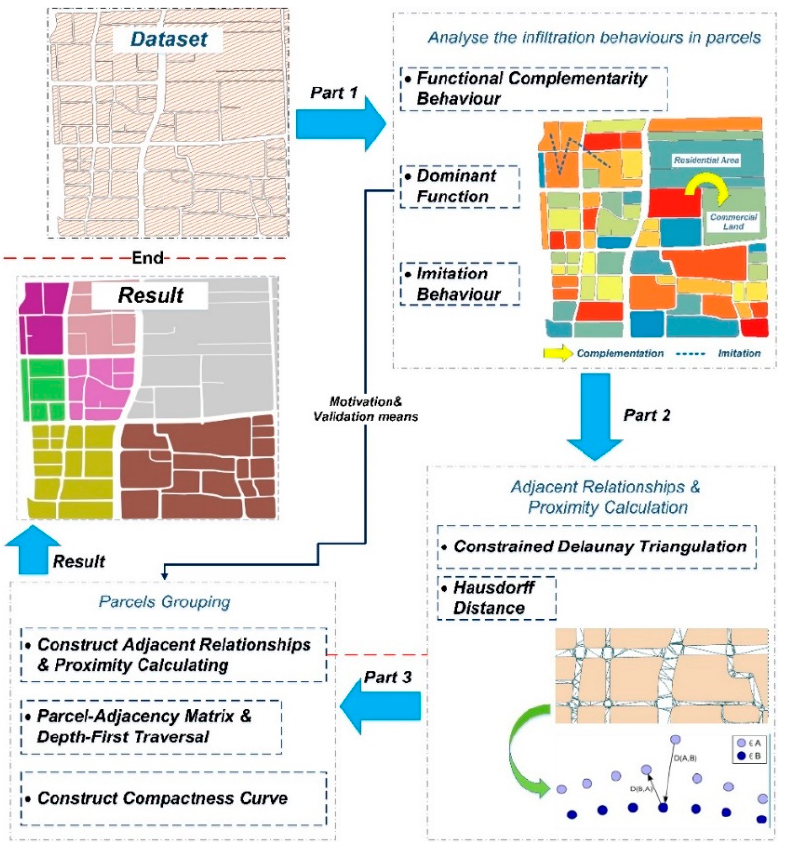
Figure 3. Overview of the procedure for urban parcel grouping.